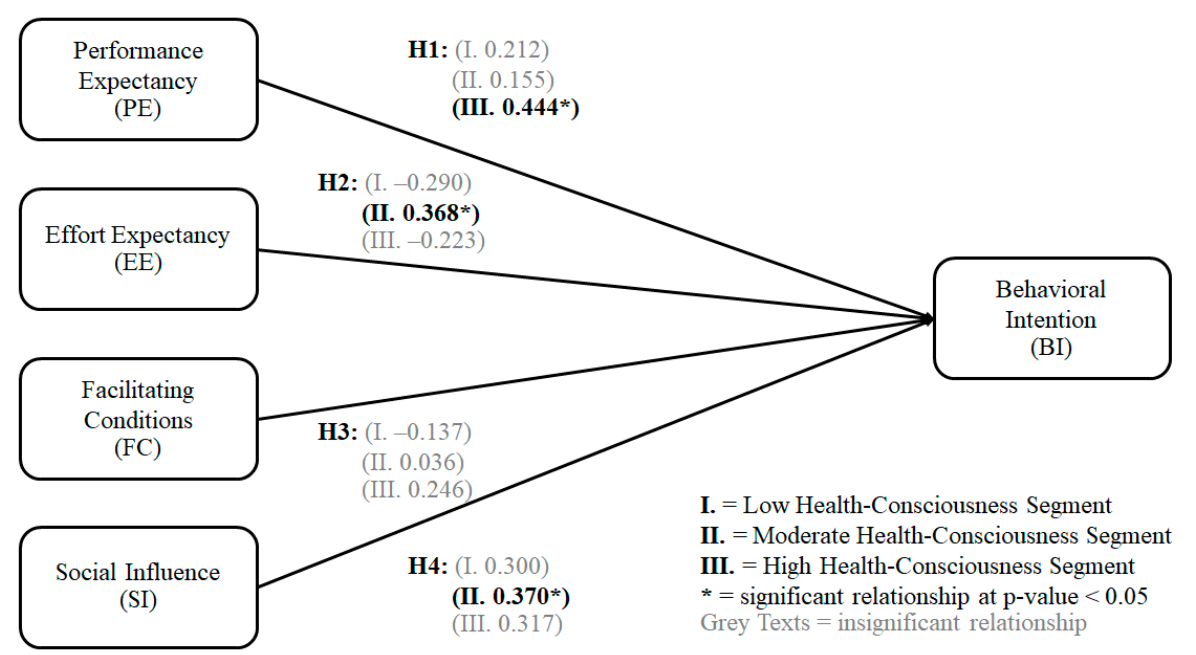
Figure 3. Multigroup structural model. (Source: figure created by authors 2023.)